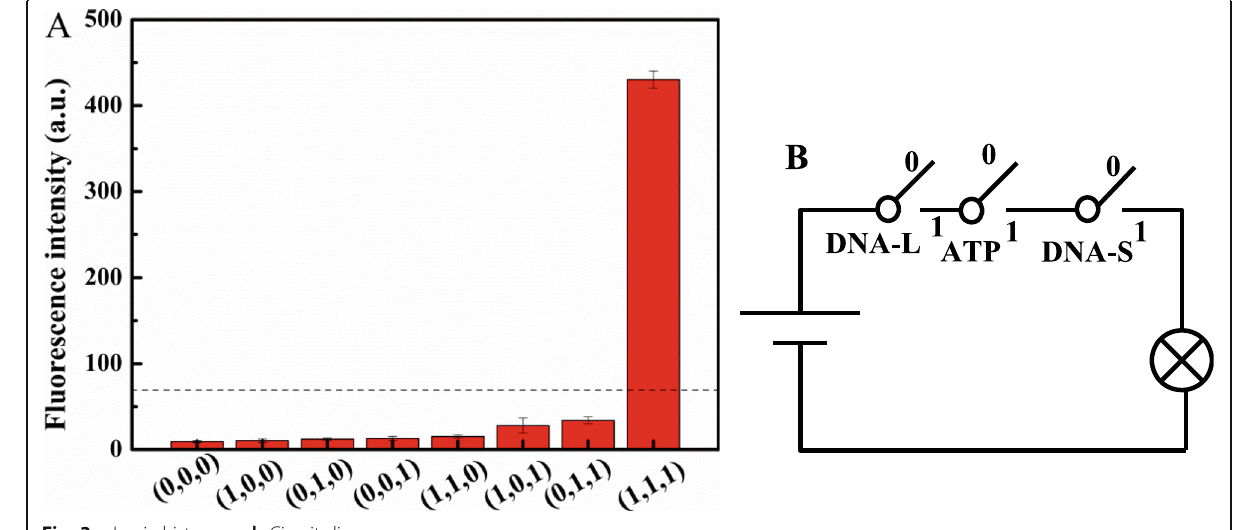
Fig. 3 a Logic histogram. b Circuit diagram